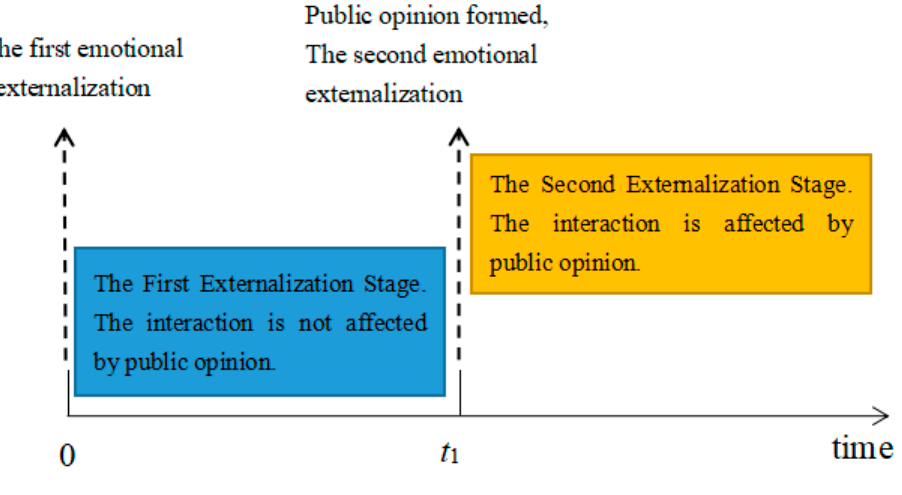
Figure 12. Times and stages.